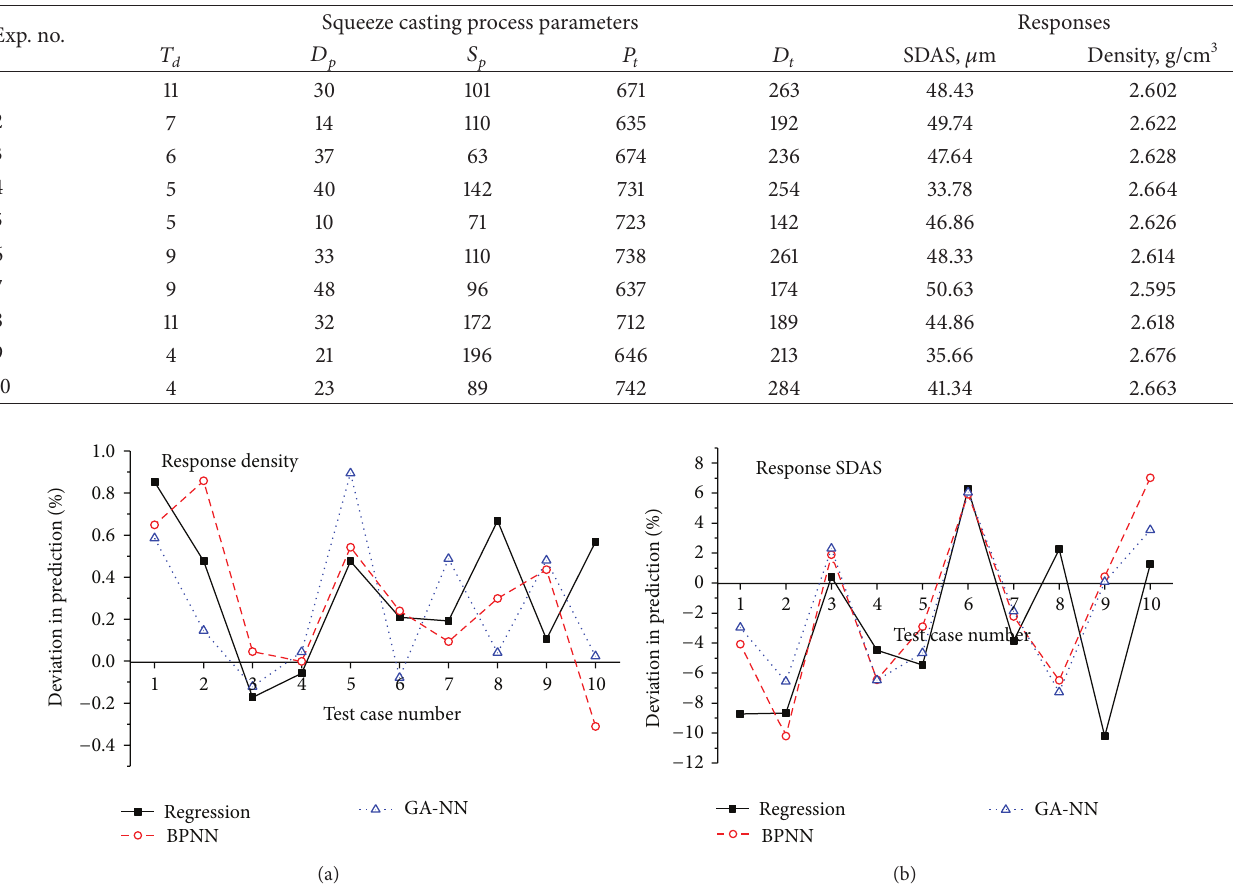
with all points on the positive side. On the other